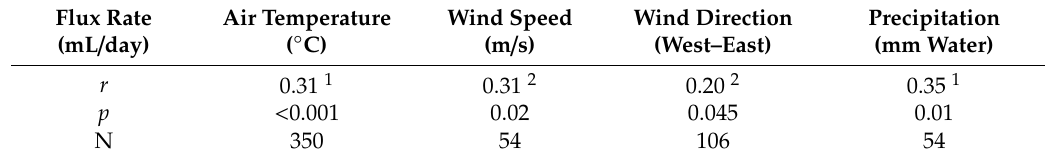
Table 3. Pearson correlation between sediment flux rate and meteorological observations.